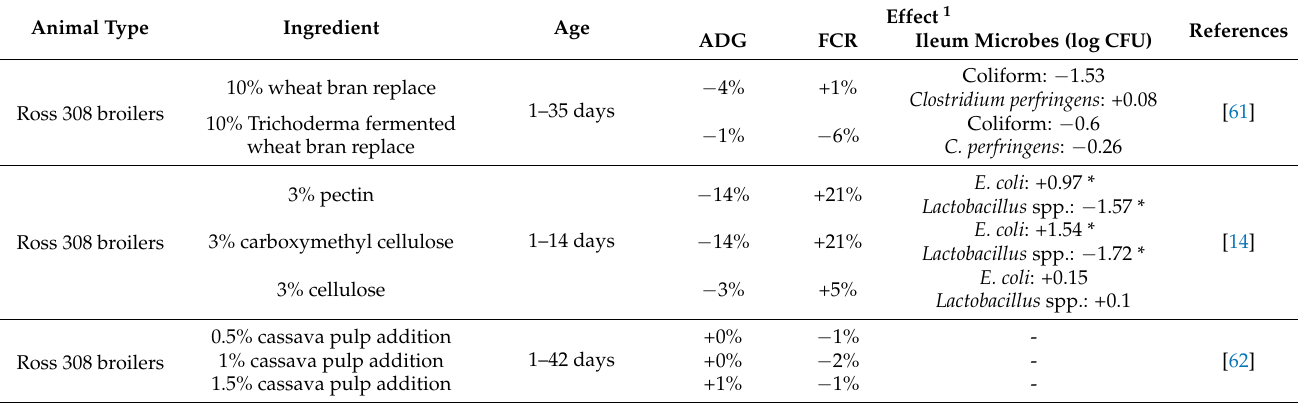
Table 1. Effect of different fiber replacement or addition on animal growth performance and the microbes in the ileum. Animal